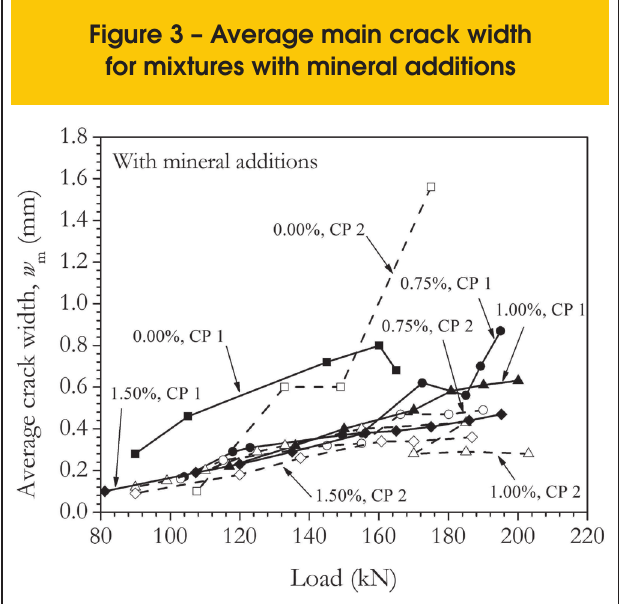
Figure 3 – Average main crack width for mixtures with mineral